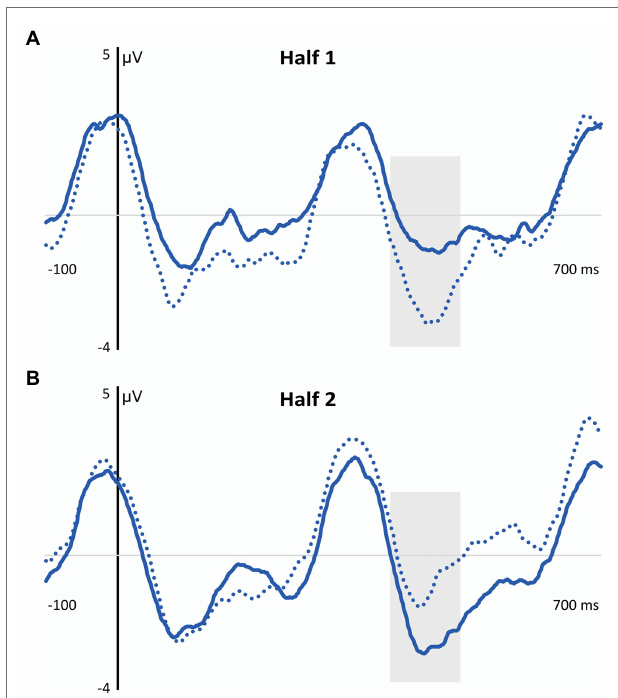
FIGURE 7 | Graphical representation of the Length of Exposure (Panel A ) and Type of “Word” (Panel B ) Effects Observed in the N400 Component in the Explicit aSL in the TLD Group. Gray shadowed rectangles indicate the N400 time window. (A) Length of exposure effect in the first half of the aSL explicit task in the TLD group. (B) “Word” effect in the second half of the explicit aSL task in the DLD group. Dark blue solid line = high-TP condition; Dark blue dotted line = low-TP